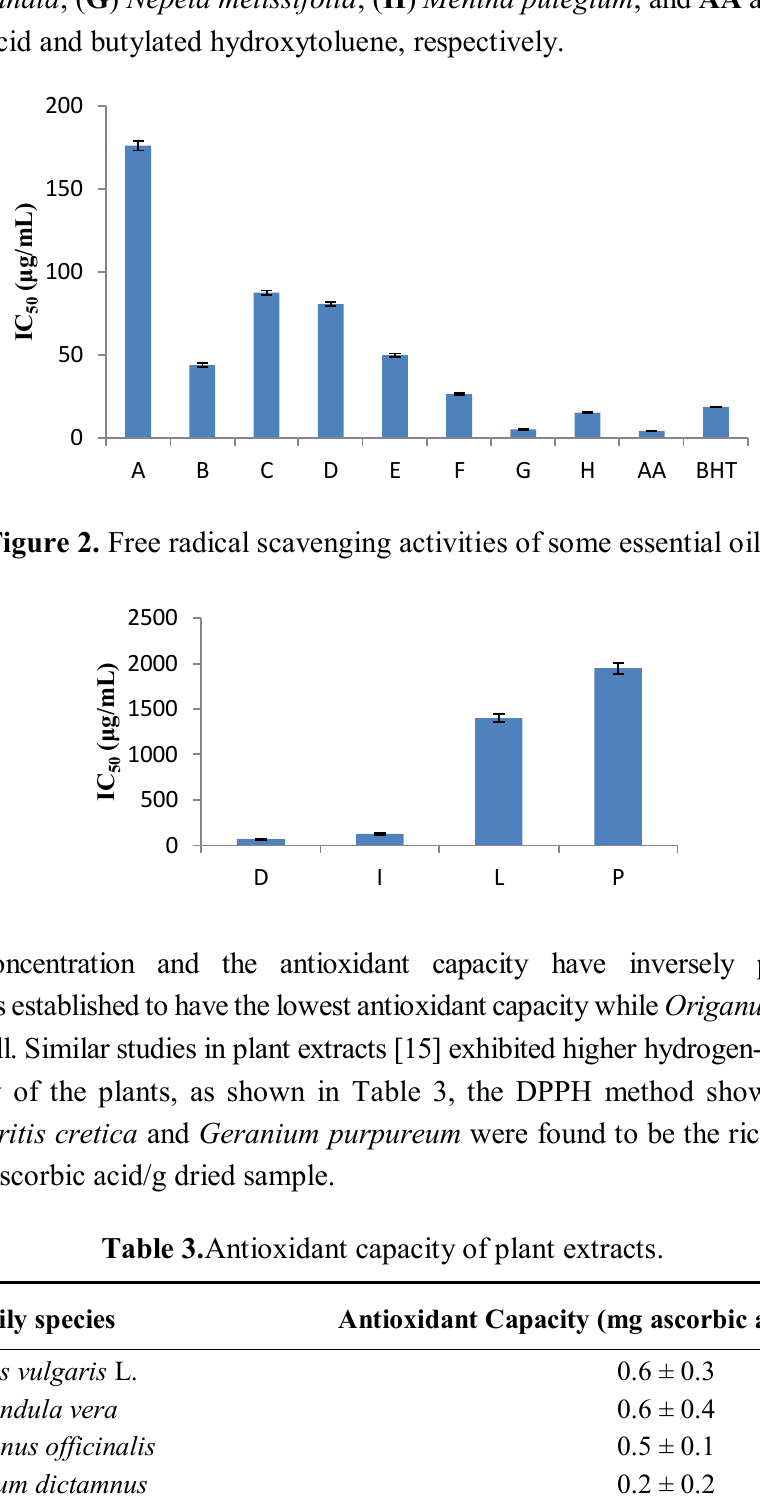
Figure 1. Free radical scavenging activities, where: ( A ) Origanum dictamnus ; ( B ) Eucalyptus globulus ; ( C ) Sideritis cretica ; ( D ) Origanum vulgare ; ( E ) Phlomis cretica ; ( F ) Phlomis lanata ; ( G ) Nepeta melissifolia ; ( H ) Mentha pulegium , and AA and BHT stand for ascorbic acid and butylated hydroxytoluene, respectively.